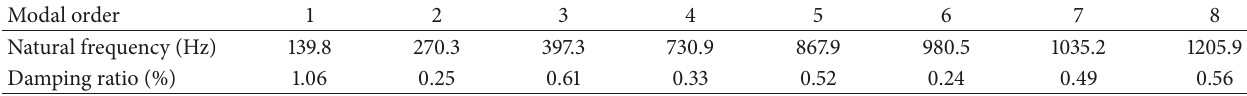
Table 1: The first 8 natural frequencies and damping ratios of composite thin plate obtained by experiment.